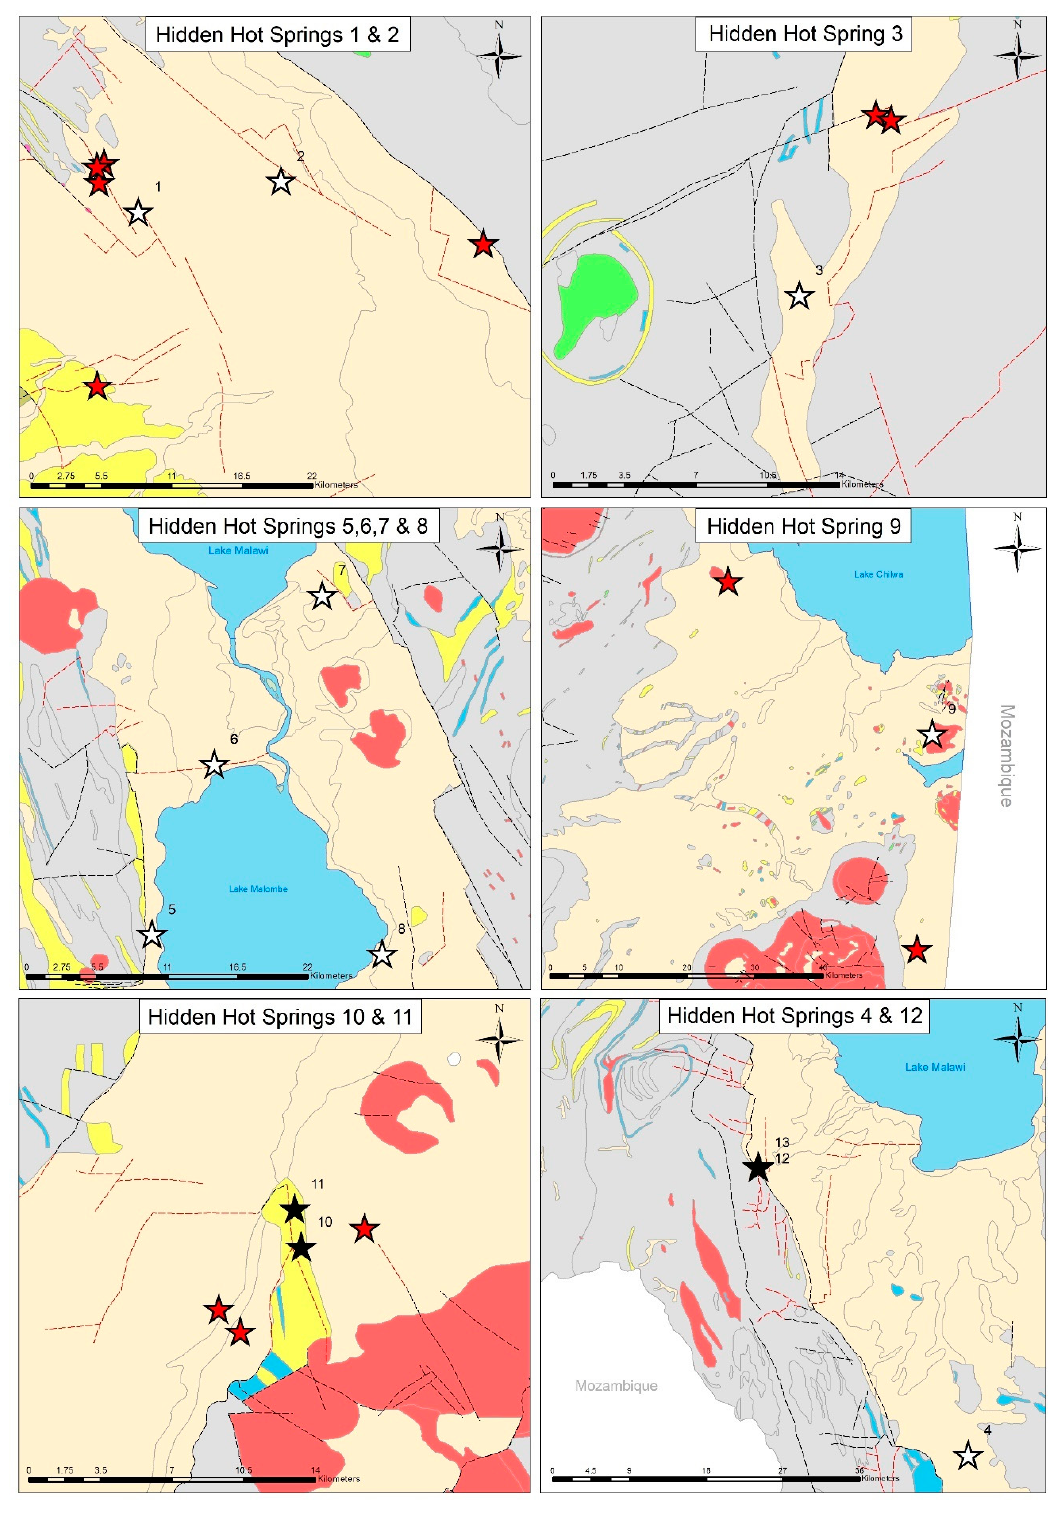
Figure 10. ( a ) Hidden hot spring vulnerability prediction map of the southern part of Malawi. Data are plotted onto regional geology to provide geological context to hidden hot spring locations. Hidden hot springs identified from geochemical data only, and those identified from dental data which were subsequently confirmed by geochemical proxy indicators, are displayed separately. ( b ) Local-scale geological maps showing hidden hot spring locations from ( a ), scaled to provide more detail on geology, known hot spring locations and rift valley faults (observed and